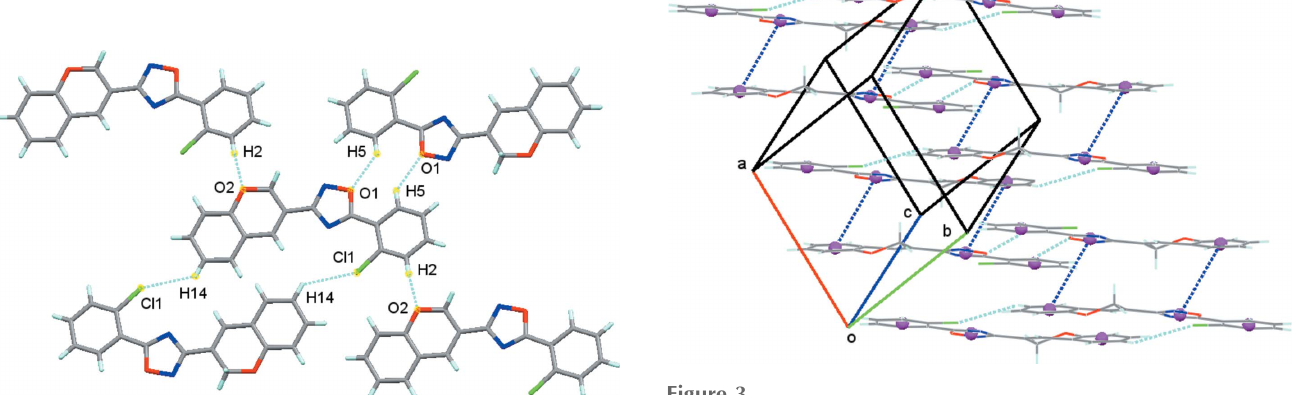
Figure 3 Packing of the title compound, showing the (cid:2) – (cid:2) interactions stacking adjacent molecular sheets (dark blue dotted lines show the (cid:2) – (cid:2) interactions and cyan dotted lines indicate hydrogen